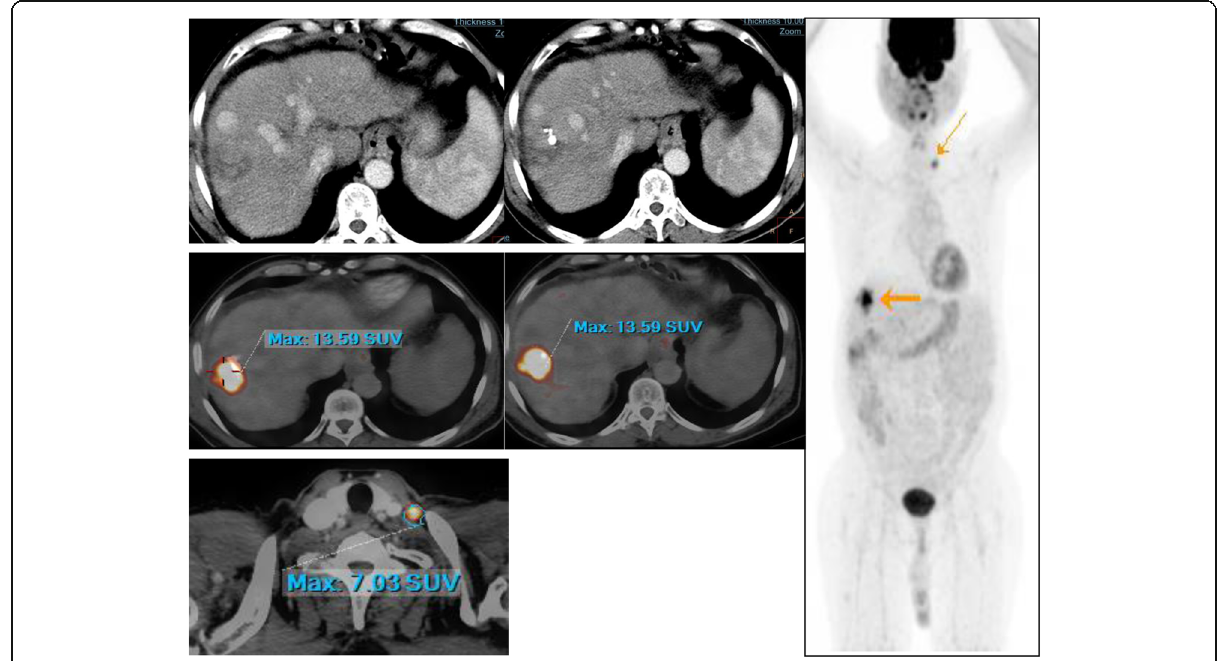
Fig. 2 A 63-year-old male having a history of HCC submitted for TACE 1.5 years ago currently presented with AFP 269. Diagnostic CT was negative, yet persistent rising of AFP PET revealed intense metabolic activity of the whole lesion achieving 13.5 SUVmax with metastatic left supra clavicular LN [7.03